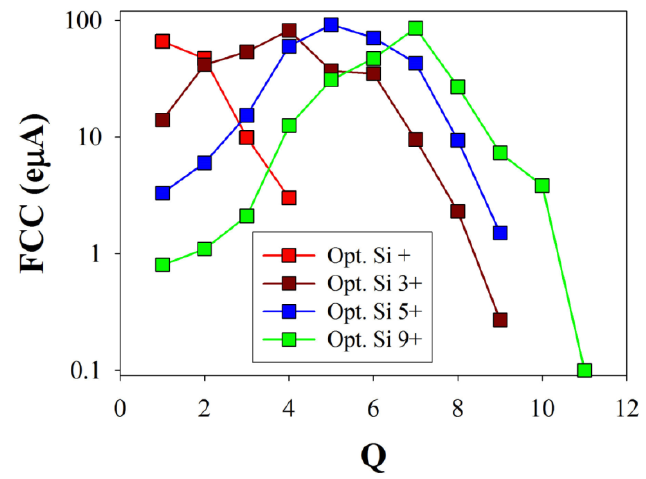
Figure 2. Charge state distributions of the analyzed silicon ion beam spectra as a function of the optimized charge states.